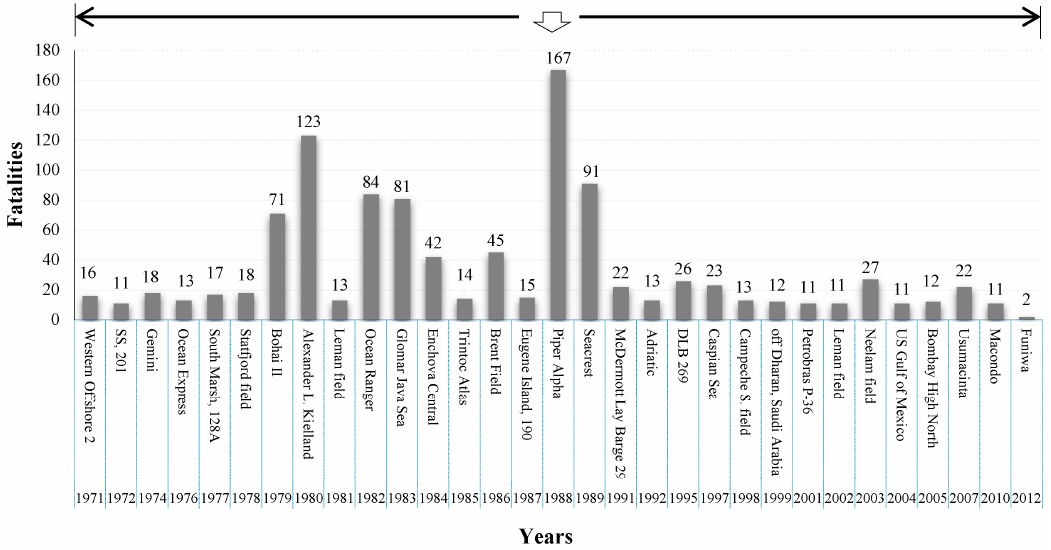
Figure 1. Process of accident trends in the oil and gas industry from 1971 to 2012 [5].